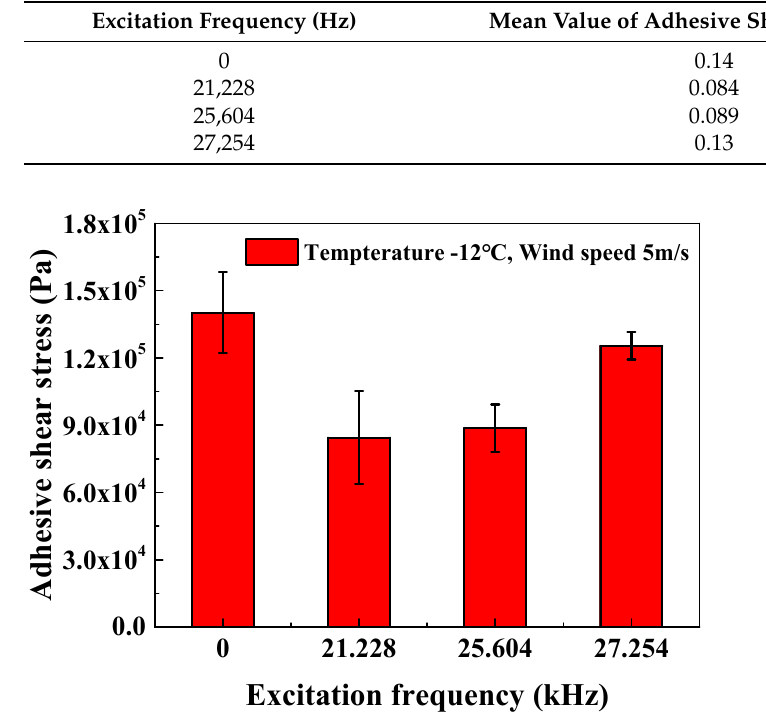
Table 4. Adhesive shear stress under the excitation frequencies.